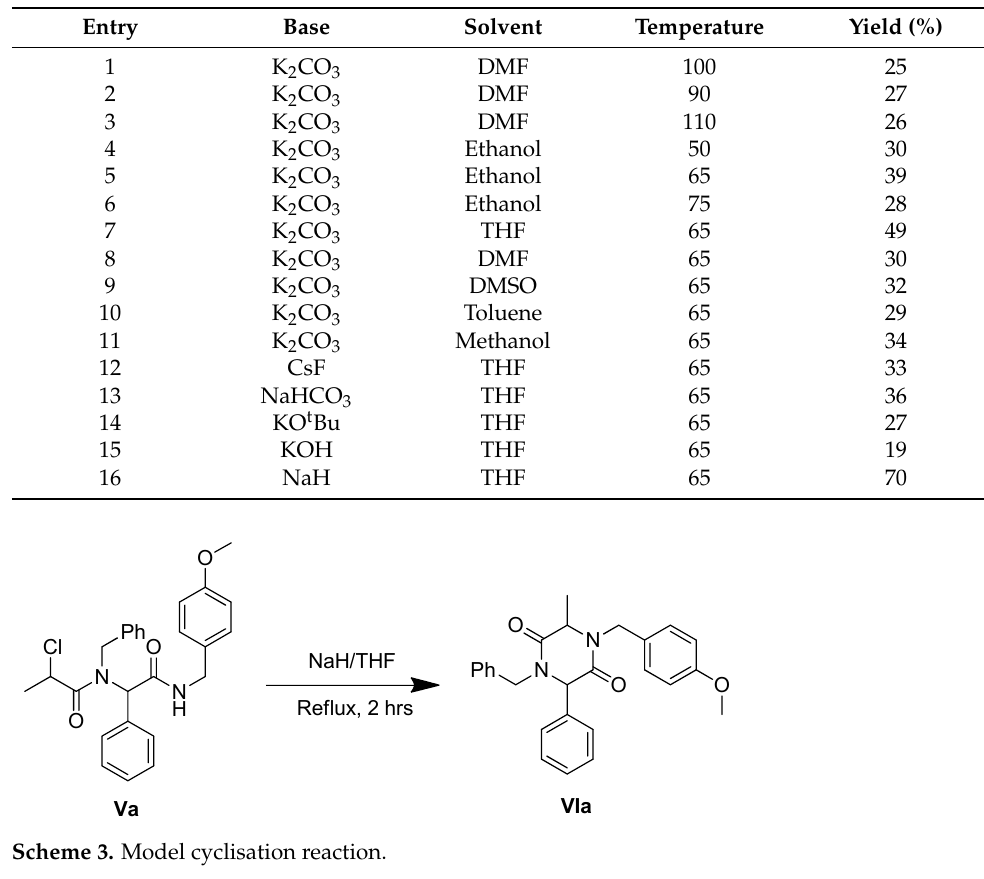
Figure 3. Minimum inhibitory concentration (MIC) of the phosphonate derivatives in model bac- terial strains. The x -axis features compounds 1 – 16 used sequentially. The y -axis shows the MIC value in μ g/mL − 1 Investigated strains of E. coli K12 as control (blue), R2 strains (orange), R3 strain (grey), and R4 strain (yellow). The y -axis shows the MBC value in μ g/mL − 1 . The order in which the compounds were applied to the plate is shown in Supplementary Materials Figure S1.